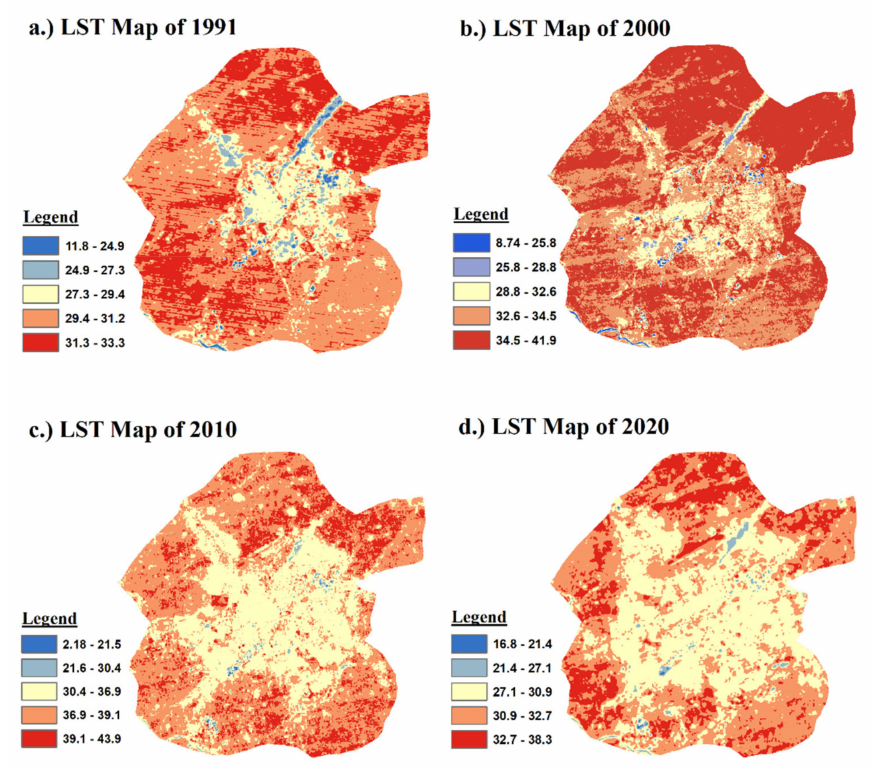
Figure 11. LST Maps of Kano Metropolis in ( a ) 1991, ( b ) 2000, ( c ) 2010, and ( d )